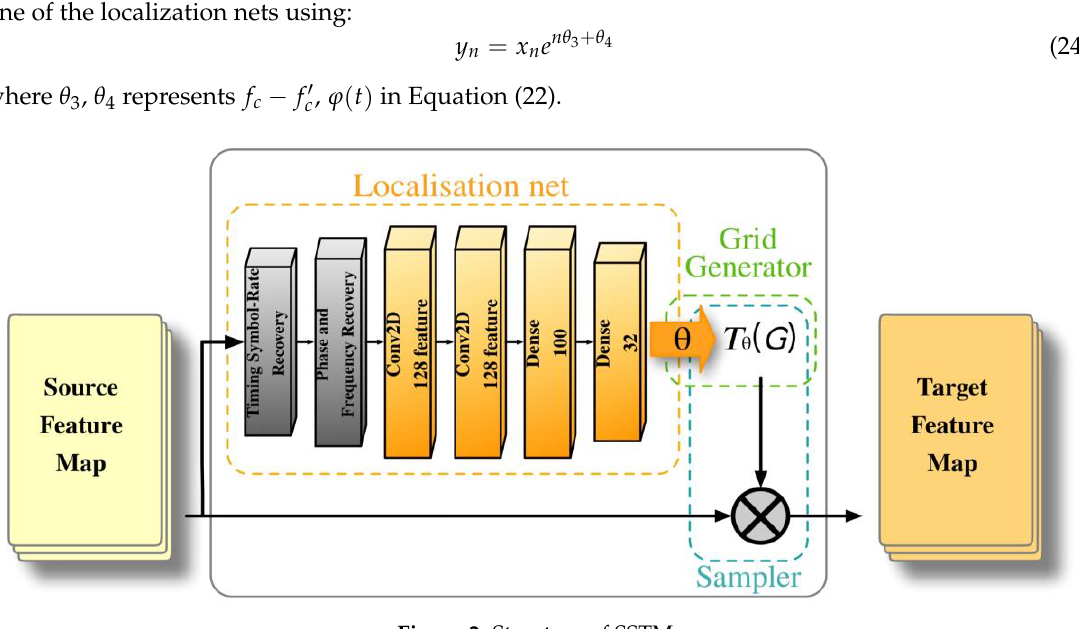
Figure 2. Structure of SSTM.